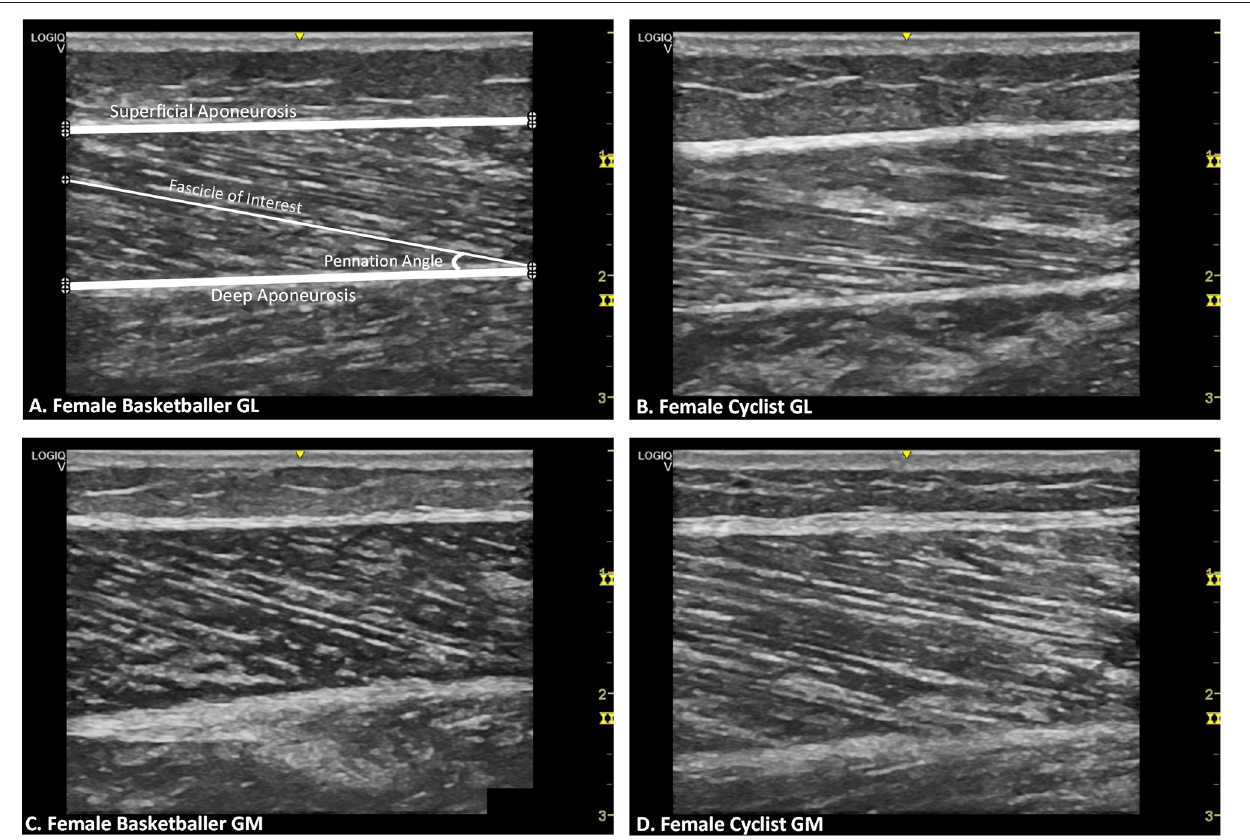
FIGURE 2 | Representative B-mode ultrasound images for female athletes by muscle and training group. (A) Gastrocnemius lateralis (GL) of female basketballer Points of interest plotted on the image ( ⊕ ) are for superficial aponeurosis borders, deep aponeurosis borders, and a selected fascicle length with the corresponding pennation angle. (B) GL of female cyclist. (C) Gastrocnemius medialis (GM) of female basketballer. (D) GM of female cyclist.